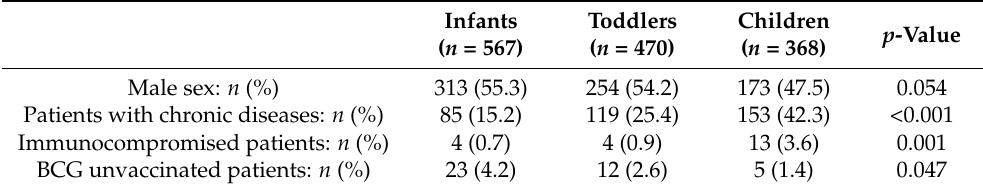
Table 1. Demographic characteristics of hospitalized COVID-19 pediatric patients in the infant, toddler, and children groups.